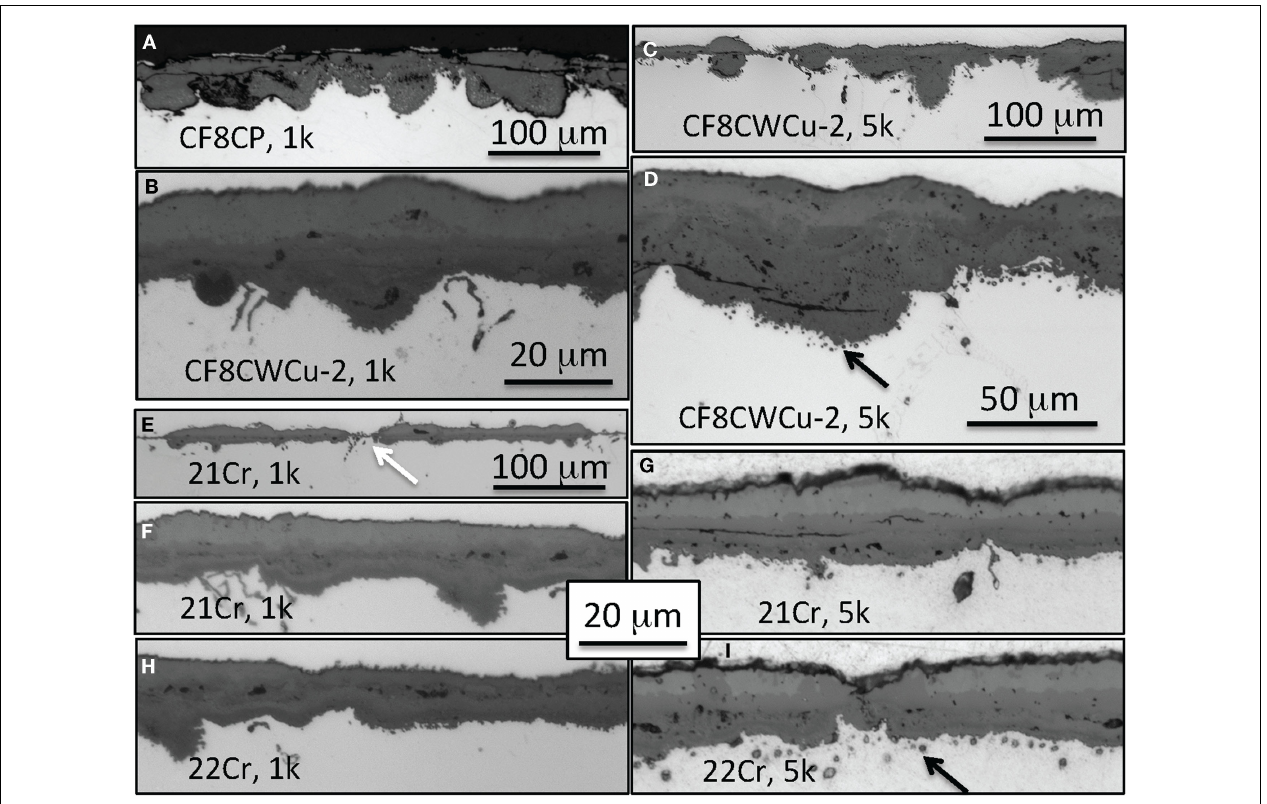
FIGURE 8 | Cross-section optical micrographs after exposure in air +++ 10% H 2 O at 750°C, (A) CF8CP, 1000h, (B) CF8CWCu-2, 1000h, (C,D) CF8CWCu-2, 5000h, (E,F) 21Cr–15Ni, 1000h, (G) 21Cr–15Ni, 5000h (H) 22Cr–17.5Ni, 1000h, and (I) 22Cr–17.5Ni, 5000h .